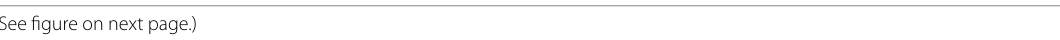
figure on next Fig. 1 Rapamycin prevented the formation of cataracts in diabetic rats. Diabetic rats (DC) were induced by STZ. Rats in the normal control group (NC) were injected with the corresponding volume of citric acid-sodium citrate buffer. Diabetic rats were treated with DMSO solvent (DMSO) and rapamycin (RAPA) respectively. Body weight ( A , n 10) and random blood glucose levels ( B , n 10) of rats were examined after treatment with = = rapamycin for 0 (before treatment), 4 and 8 w. ( C , D ) Lenses of rats in each group (n 20) were observed and photographed under a slit lamp = microscope at 0 w, 4 w and 8 w after treatment with rapamycin. E , F H&E staining showed histological changes in the lens (n 4). ns indicates = P > 0.05; ** P < 0.01 and **** P < 0.0001 vs. NC group; # P < 0.05 and ### P < 0.001 vs. DC group; ★ P < 0.05 and ★★ P < 0.01 vs. DMSO